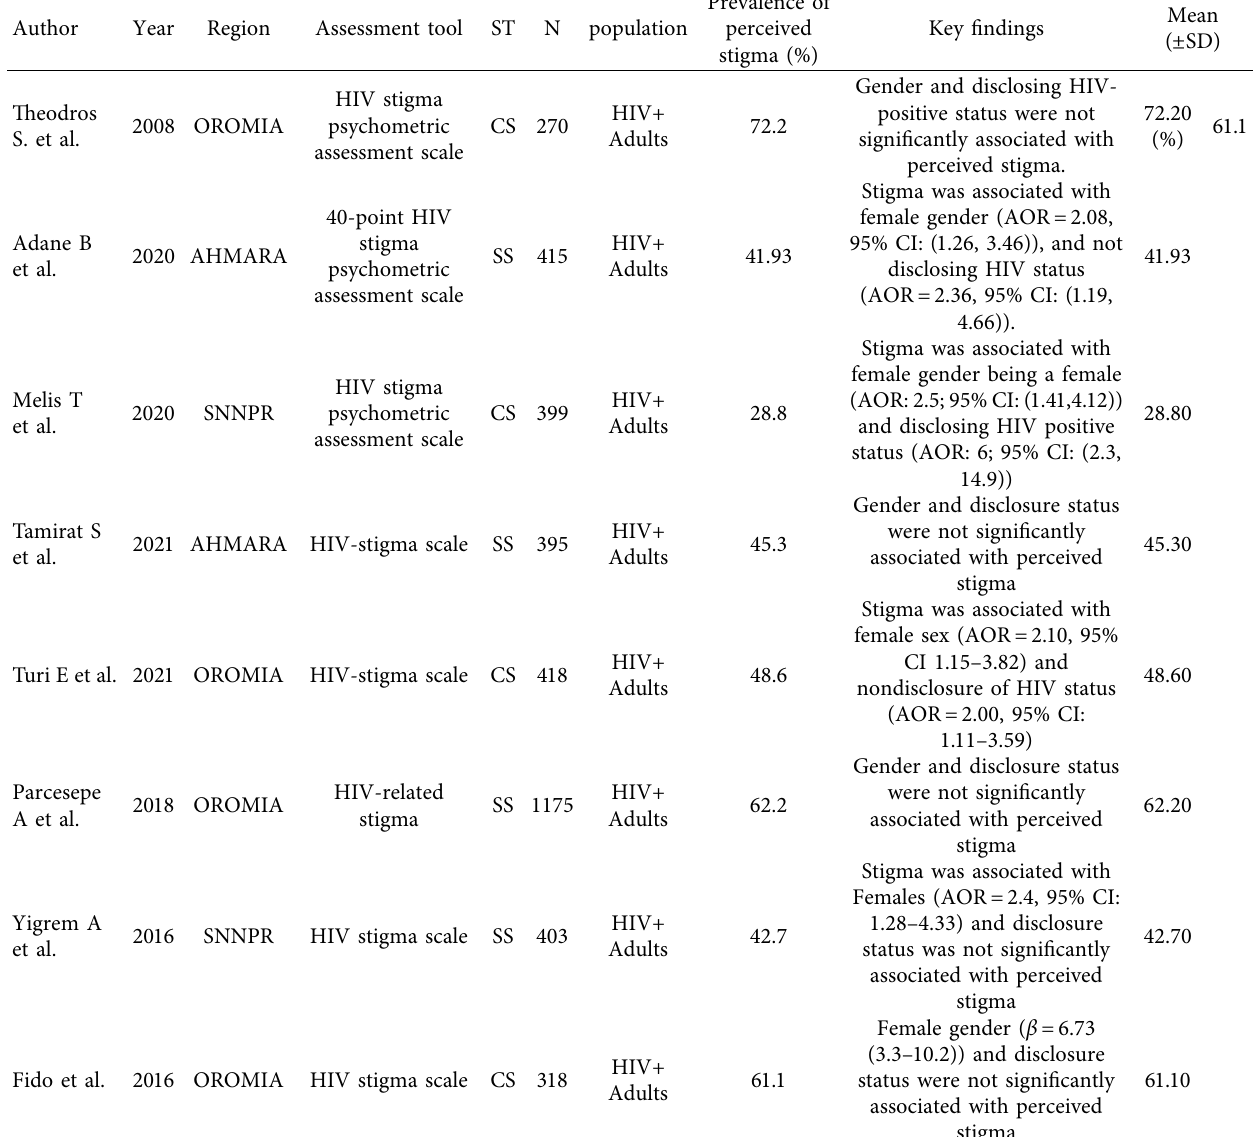
Table 1: The characteristics studies are included in the current systematic review and